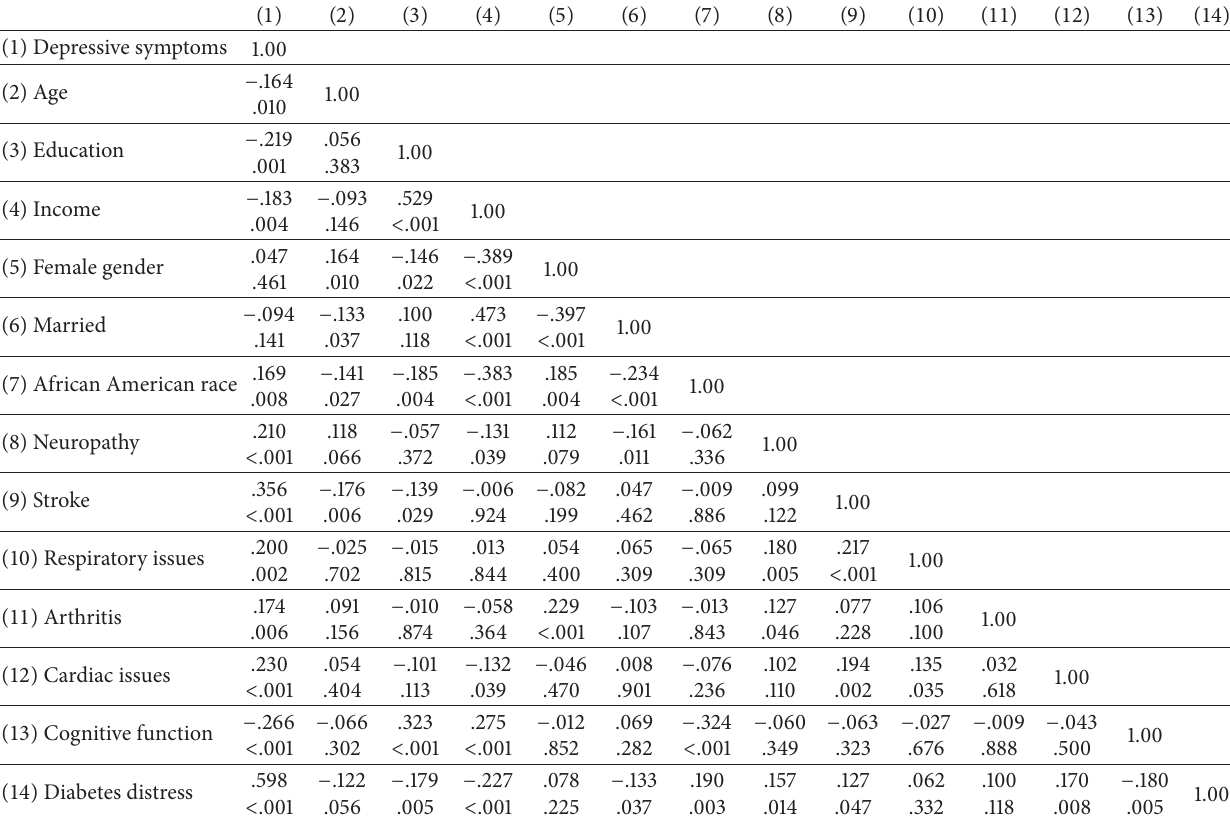
Table 2: Correlations among depressive symptoms, demographic factors, health, and diabetes